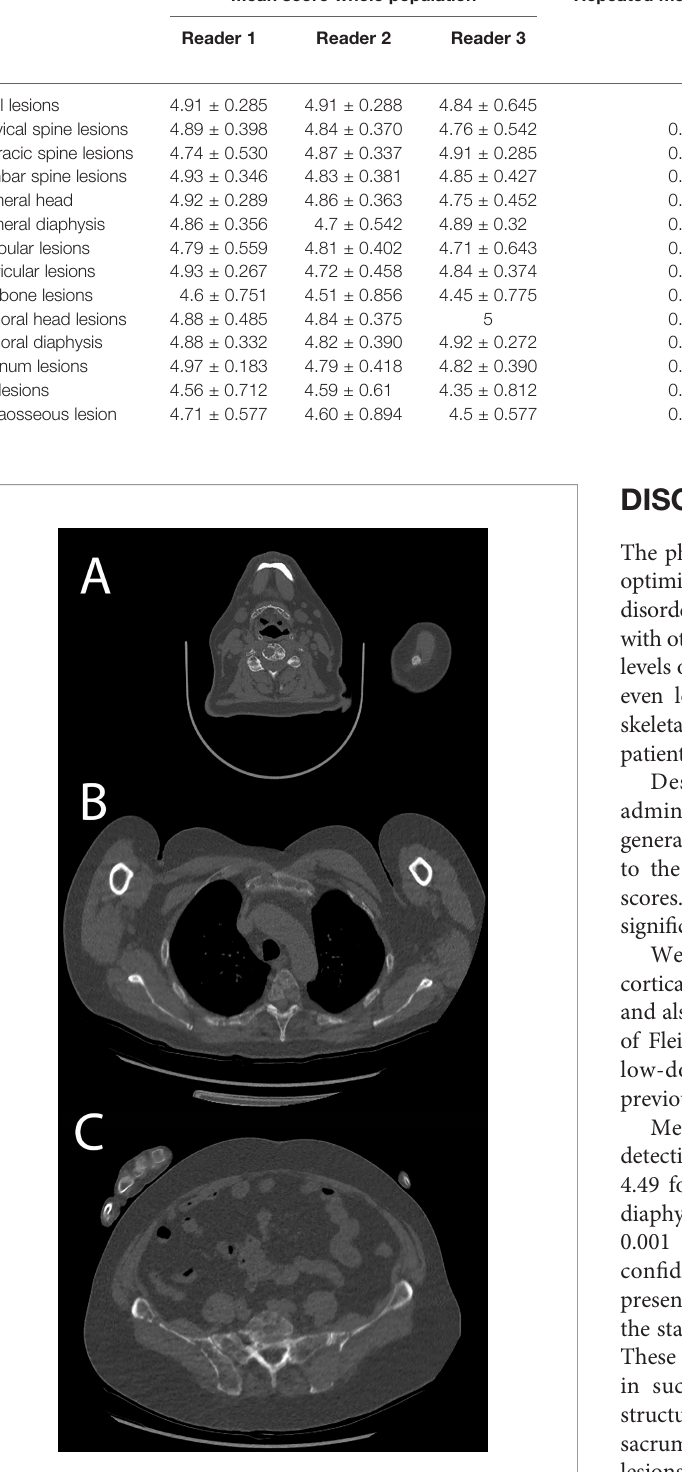
FIGURE 6 | Patient acquired with standard protocol. (A) Cervical spine osteolytic lesions. (B) Thoracic spine and sternal and costal lesions. (C) Sacrum and hip bone